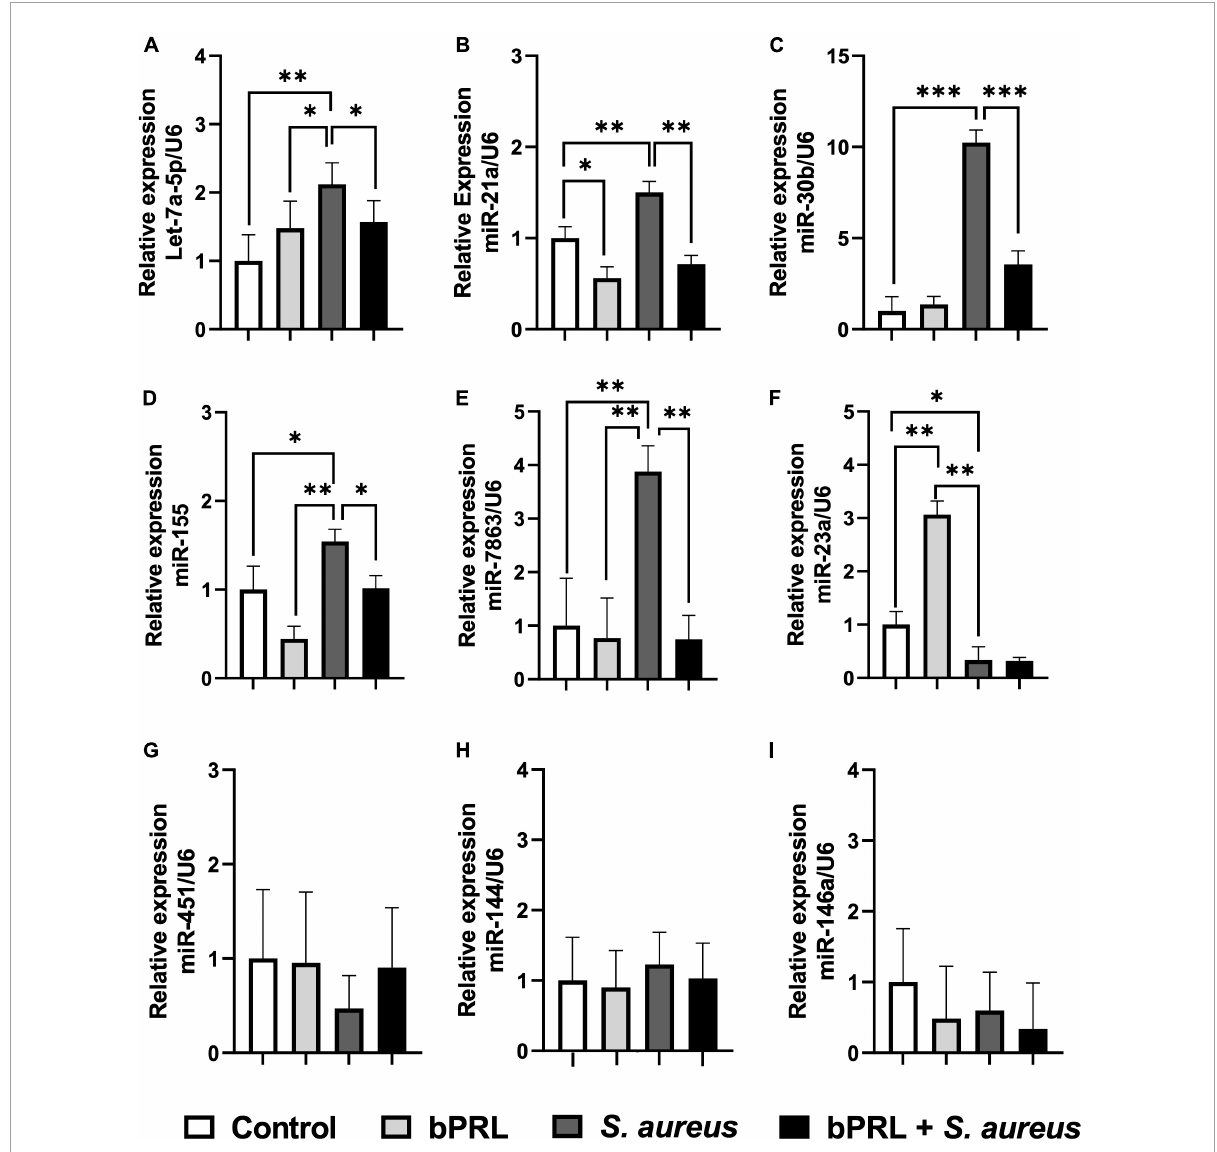
FIGURE4 Bovine prolactin regulates the miRNAs expression in bMECs during S. aureus challenge. bMECs were treated 12 h with bPRL (5 ng/ml) and then were or not challenged for 2 h with S. aureus (MOI = 30:1). The RT-qPCR assay using the (cid:49)(cid:49) Ct comparative method was performed to evaluate the expression of miRNAs Let-7a-5p (A) , miR-21a (B) , miR-30b (C) , miR-155 (D) , miR-7863 (E) , miR-23a (F) , miR-451 (G) , miR-144 (H) , miR-146a (I) . Control, bMECs without any treatment; bPRL, bMECs treated 12 h with bPRL (5 ng/ml); bPRL + S. aureus , bMECs treated 12 h with bPRL (5 ng/ml) and challenged with S. aureus for 2 h (MOI = 30:1); S. aureus , bMECs only challenged with S. aureus (MOI = 30:1). Data were normalized regarding internal control U6. Each bar shows the mean ± SE and was analyzed using t -student and Wilcoxon tests from